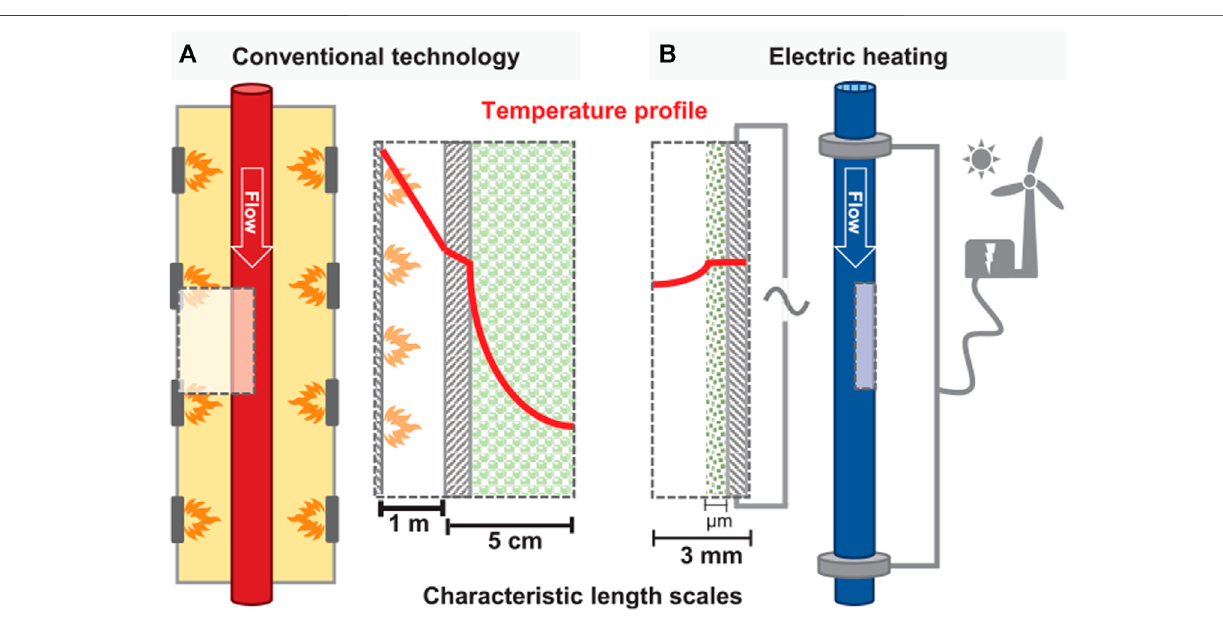
Frontiers in Chemical Engineering |